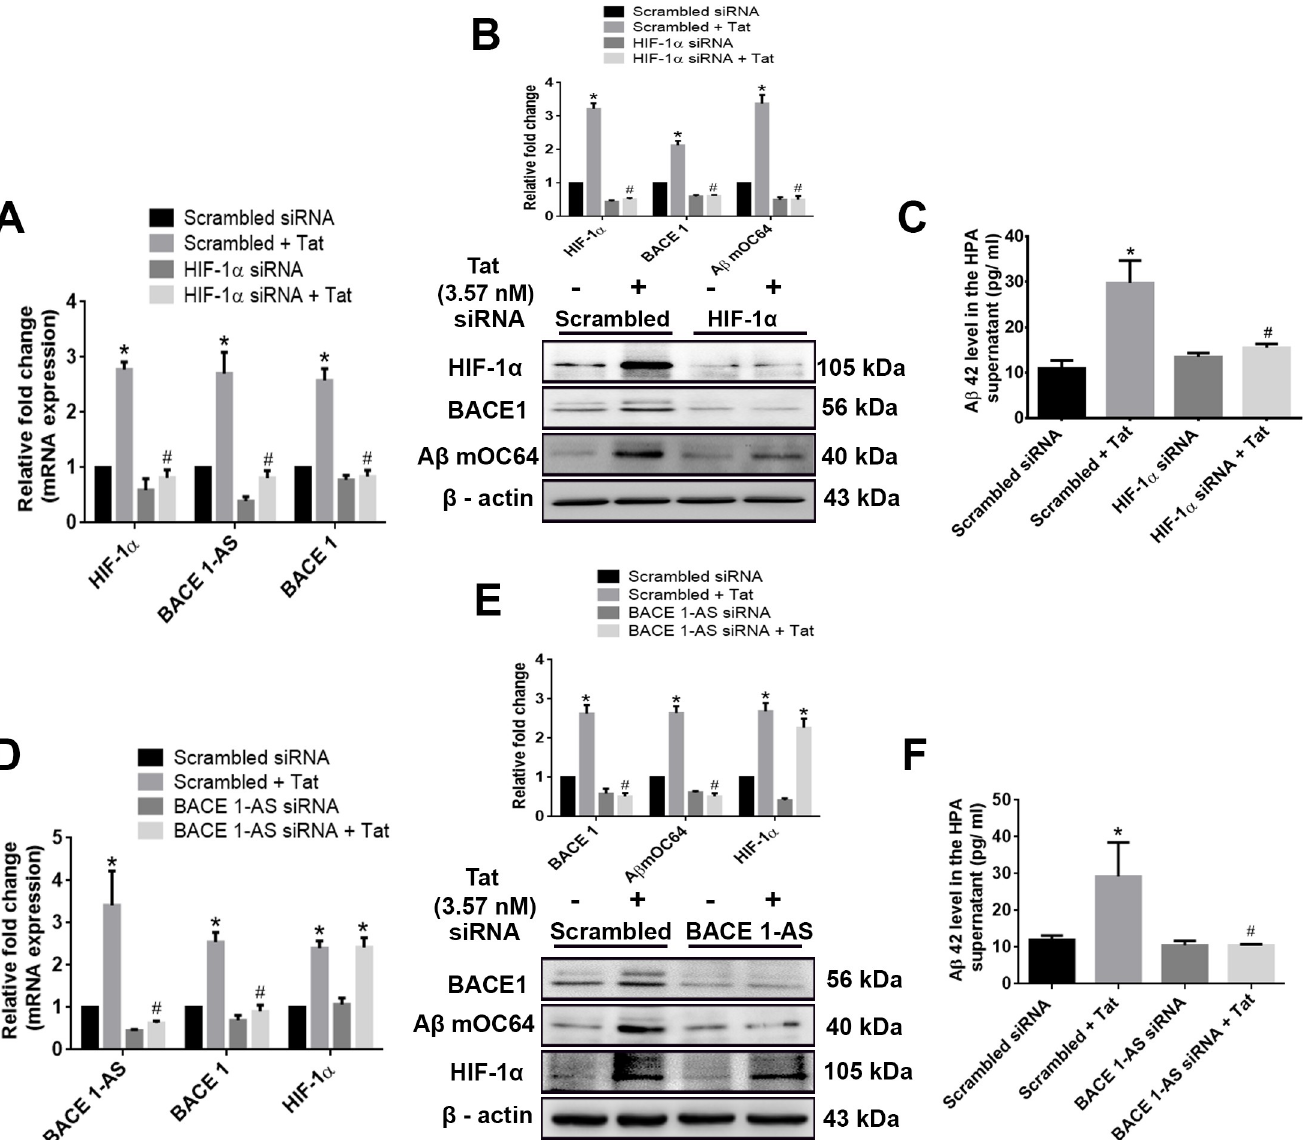
Fig 7. HIV-1 Tat–mediated regulation of HIF-1 α , BACE1-AS, and BACE1 in modulating astrocytic amyloidosis. (A) qPCR analysis demonstrating expression of HIF-1 α , BACE1-AS, and BACE1 mRNA in HPAs transfected with either HIF-1 α or scrambled siRNA in the presence or absence of HIV-1 Tat (3.57 nM; 24 hours). (B) Representative western blots showing the expression of HIF-1 α , BACE1, and A β mOC64 proteins in HPAs transfected with either HIF-1 α or scrambled siRNA. (C) ELISA showing the protein levels of A β 42 in the supernatant fluids of HPAs transfected with either HIF-1 α or scrambled siRNA. (D) qPCR demonstrating expression of BACE1-AS, BACE1, and HIF-1 α RNA in HPAs transfected with either BACE1-AS or scrambled siRNA. (E) Representative western blots showing the expressions of BACE1, A β mOC64, and HIF-1 α in HPA transfected with either BACE1-AS or scrambled siRNA. (F) ELISA showing the protein levels of A β 42 in the supernatant of HPA transfected with either BACE1-AS or scrambled siRNA. Data are presented as mean ± SEM; n = 6. One-way ANOVA followed by Bonferroni post hoc test was used to determine the statistical significance: � P < 0.05 versus control, # P < 0.05 versus Tat. The data underlying this figure may be found in S7 Data. A β , amyloid beta; BACE1, β -site cleaving enzyme; BACE1-AS, BACE1-antisense transcript; HIF-1 α , hypoxia-inducible factor; HPA, human primary astrocyte; qPCR, quantative polymerase chain reaction; siRNA, small interfering RNA; Tat, transactivator of